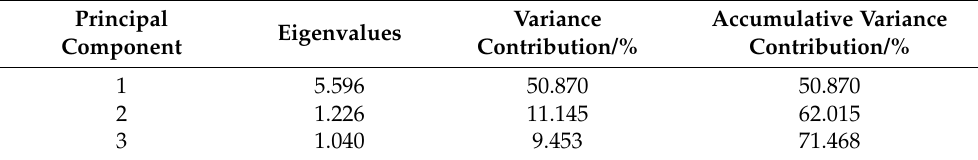
Table 4. Eigenvalues and cumulative variance contribution rates of health status assessment fac-tors in volunteers.